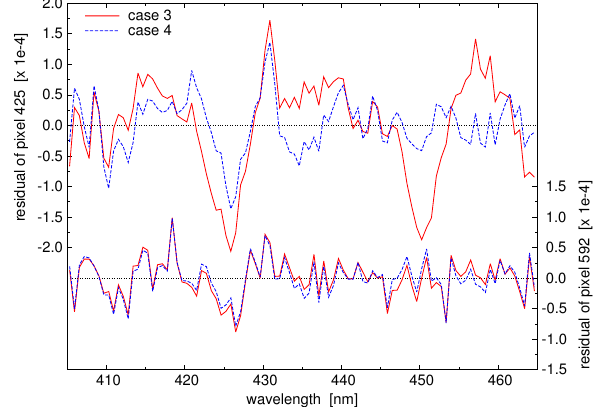
Figure 7. Spectral residual of the NO 2 retrieval fit with the up- Fig. 7. Spectral residual of the NO 2 retrieval fit with the updated reference spectra without (case 3, red solid lines) and with (case 4, blue dashed lines) O 2 –O 2 and H 2 O liq absorption included for two ground pix- dated reference spectra without (case 3, red solid lines) and with els along row 29 (0-based): pixel 425 (located at 20 . 2 ◦ S, 135 . 4 ◦ W; top two curves, left axis) and pixel 592 (case 4, blue dashed lines) O 2 –O 2 and H 2 O liq absorption included ( 0 . 0 ◦ S, 139 . 8 ◦ W;bottomtwocurves,rightaxis)ofthePacificOceantestorbit. Toclarifythegraph,thewave- for two ground pixels along row 29 (0-based): pixel 425 (located at lengths of three detector pixels are averaged, thus mimicing the fact that OMI’s spectral resolution is about 20 . 2 ◦ S, 135 . 4 ◦ W; top two curves, left axis) and pixel 592 (0 . 0 ◦ S, threetimesitsspectralsampling. 139 . 8 ◦ W; bottom two curves, right axis) of the Pacific Ocean test orbit. To clarify the graph, the wavelengths of three detector pixels are averaged, thus mimicking the fact that OMI’s spectral resolution is about 3 times its spectral